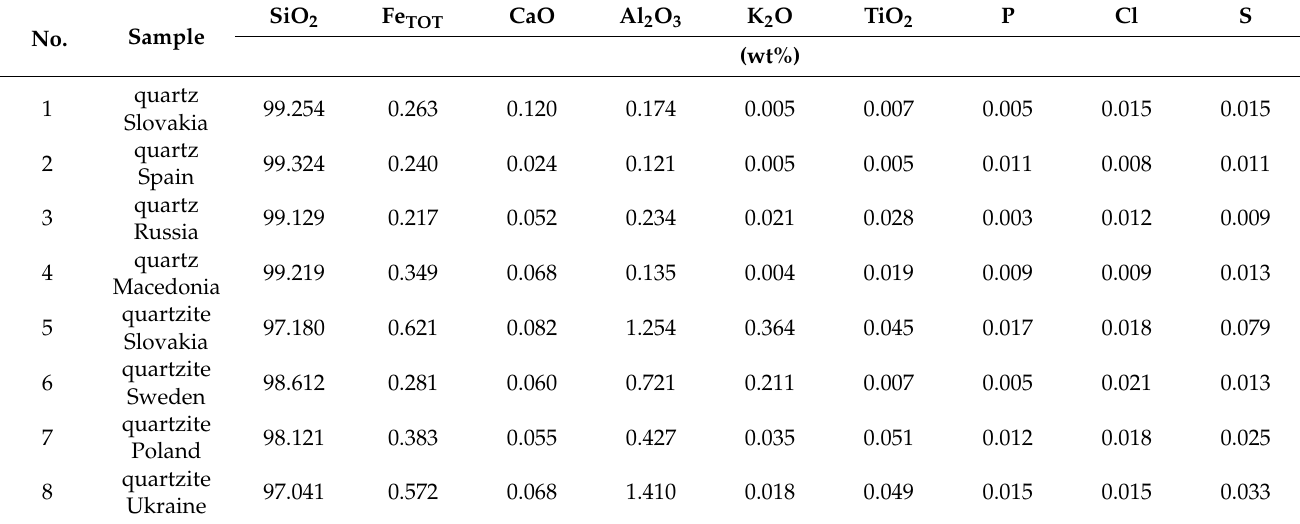
Table 4. Average chemical composition of tested samples determined by